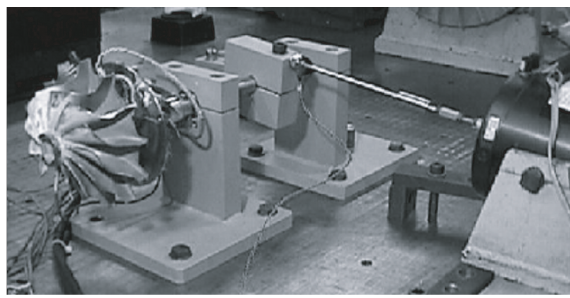
Figure 9: Setup of the model experiment for measuring blade stress excited by torsional